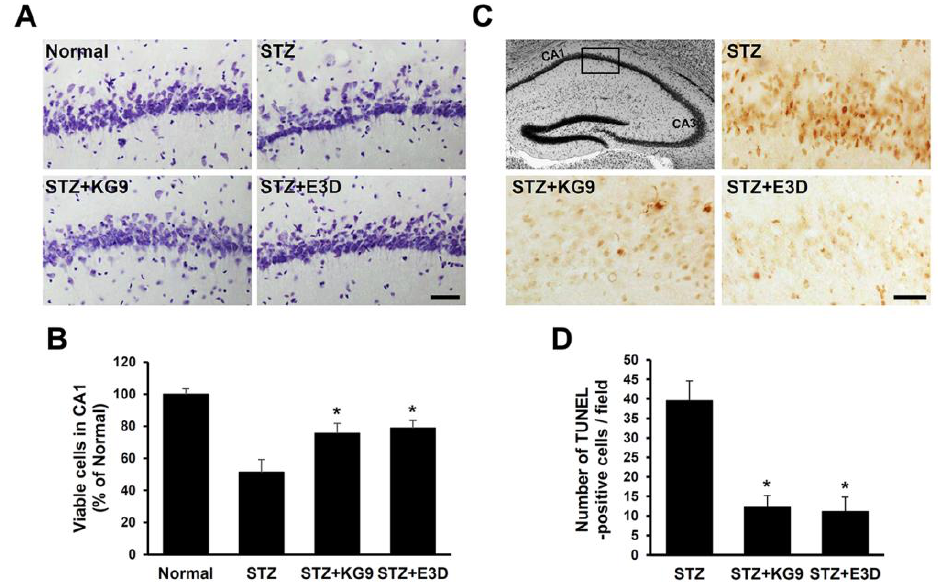
Figure 9. GS-KG9 and GS-E3D inhibit apoptotic cell death of hippocampal neurons in STZ-induced diabetic rats. At 28 d after GS-KG9 and GS-E3D (300 mg / kg) treatment, brain tissue samples were prepared and stained with Cresyl violet and TUNEL (Terminal deoxynucleotidyl transferase dUTP nick end labeling)-stained as described in the Materials and Methods. ( A ) Representative photomicrographs of Nissl staining of the hippocampus CA1 area. Scale bar, 50 µ m. ( B ) Quantification of viable cells in CA1 area ( n = 5 rats / group). ( C ) Representative images of TUNEL staining in CA1 (rectangular box in the brain atlas of left-top panel). Scale bars, 50 µ m. ( D ) Quantitative analysis of TUNEL-positive cells ( n = 5 rats / group). Note that GS-KG9 and GS-E3D significantly decreased the number of TUNEL-positive hippocampal neurons in CA1 area in STZ-induced diabetic rats as compared to STZ control. All data are presented as the mean ± SD. * p < 0.05 vs. STZ control.